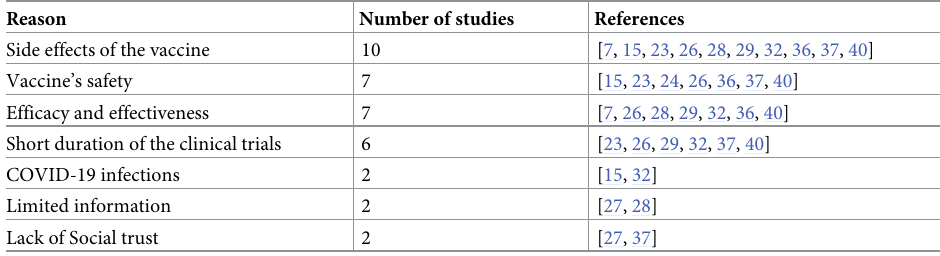
Table 3. Reasons for COVID-19 vaccine hesitancy among HCWs in